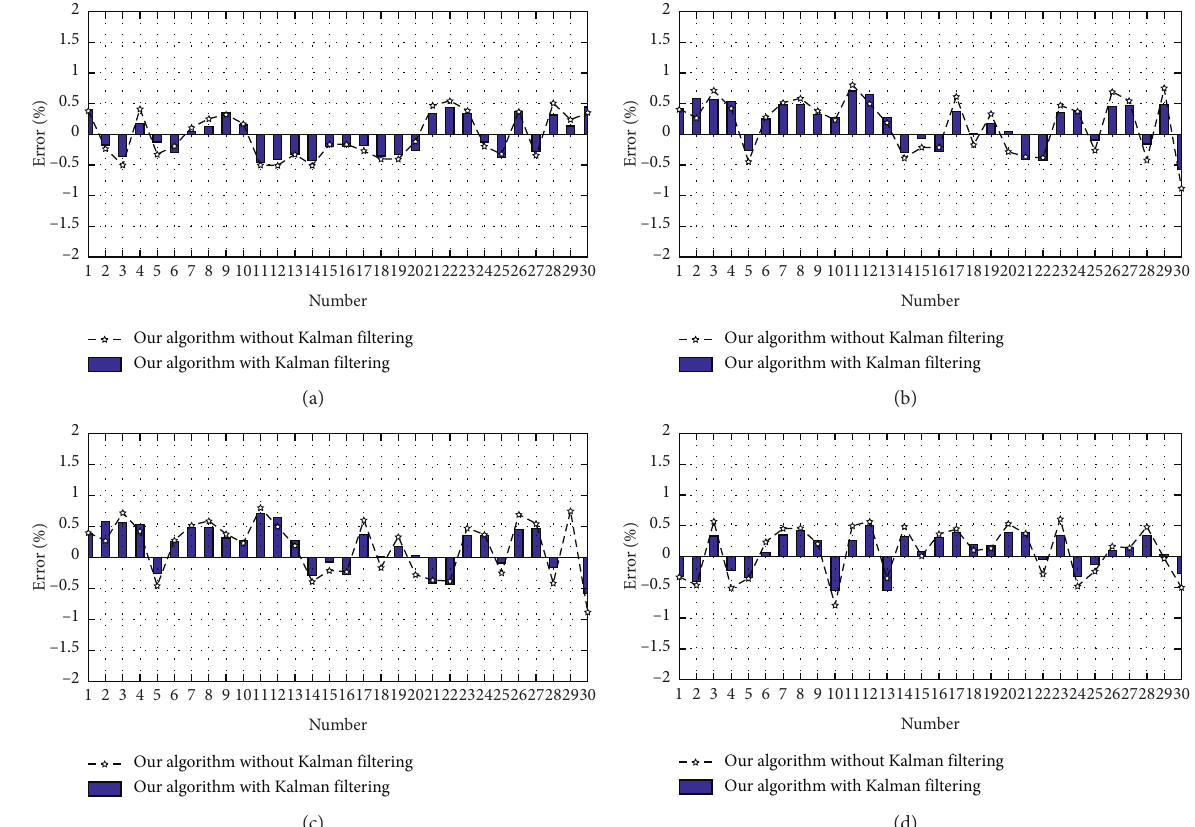
Figure 11: The error plot of men in the six consecutive seconds. (a–d) The men with static heights of 1760, 1676, 1761, and